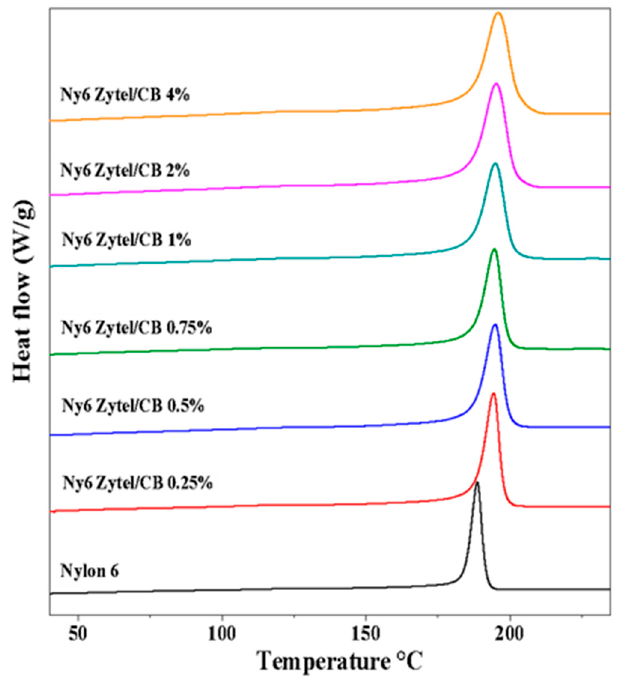
Figure 4. Crystallization exotherms obtained by DSC from Nylon 6 nonwoven fabrics and Ny6 Zytel/CB nonwoven fabrics at different concentrations (0.25, 0.5, 0.75, 1.0, 2.0, and 4.0 w%).